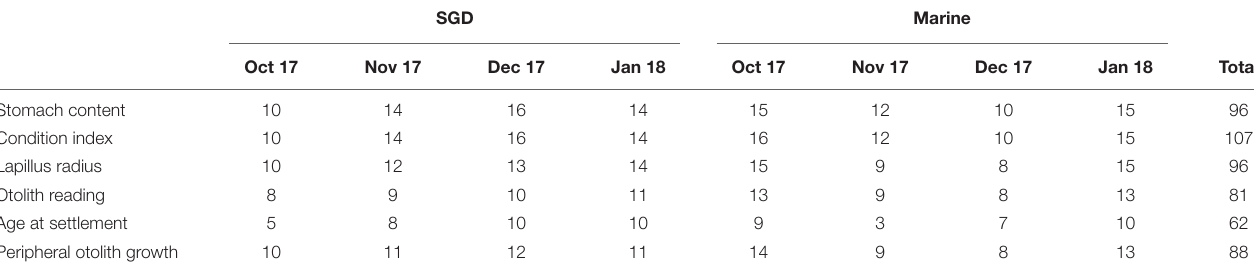
TABLE 1 | Number of juvenile Chrysiptera glauca used for the respective